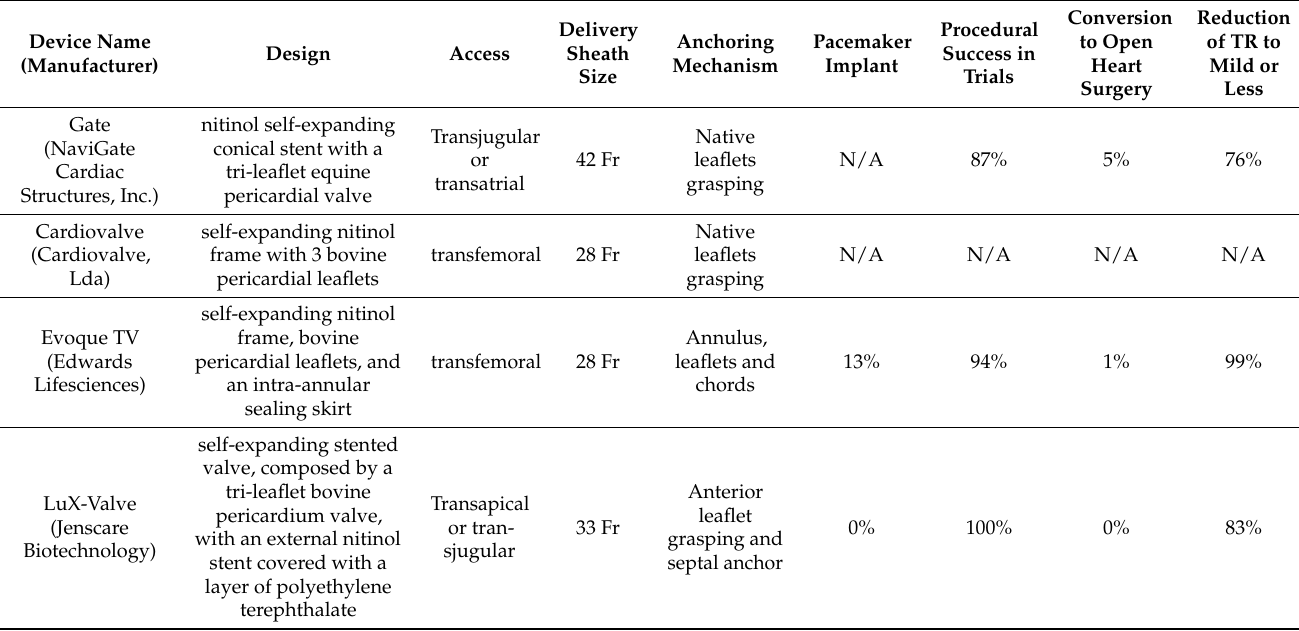
Table 1. Transcatheter tricuspid valve replacement devices with larger reported experience in the clinical